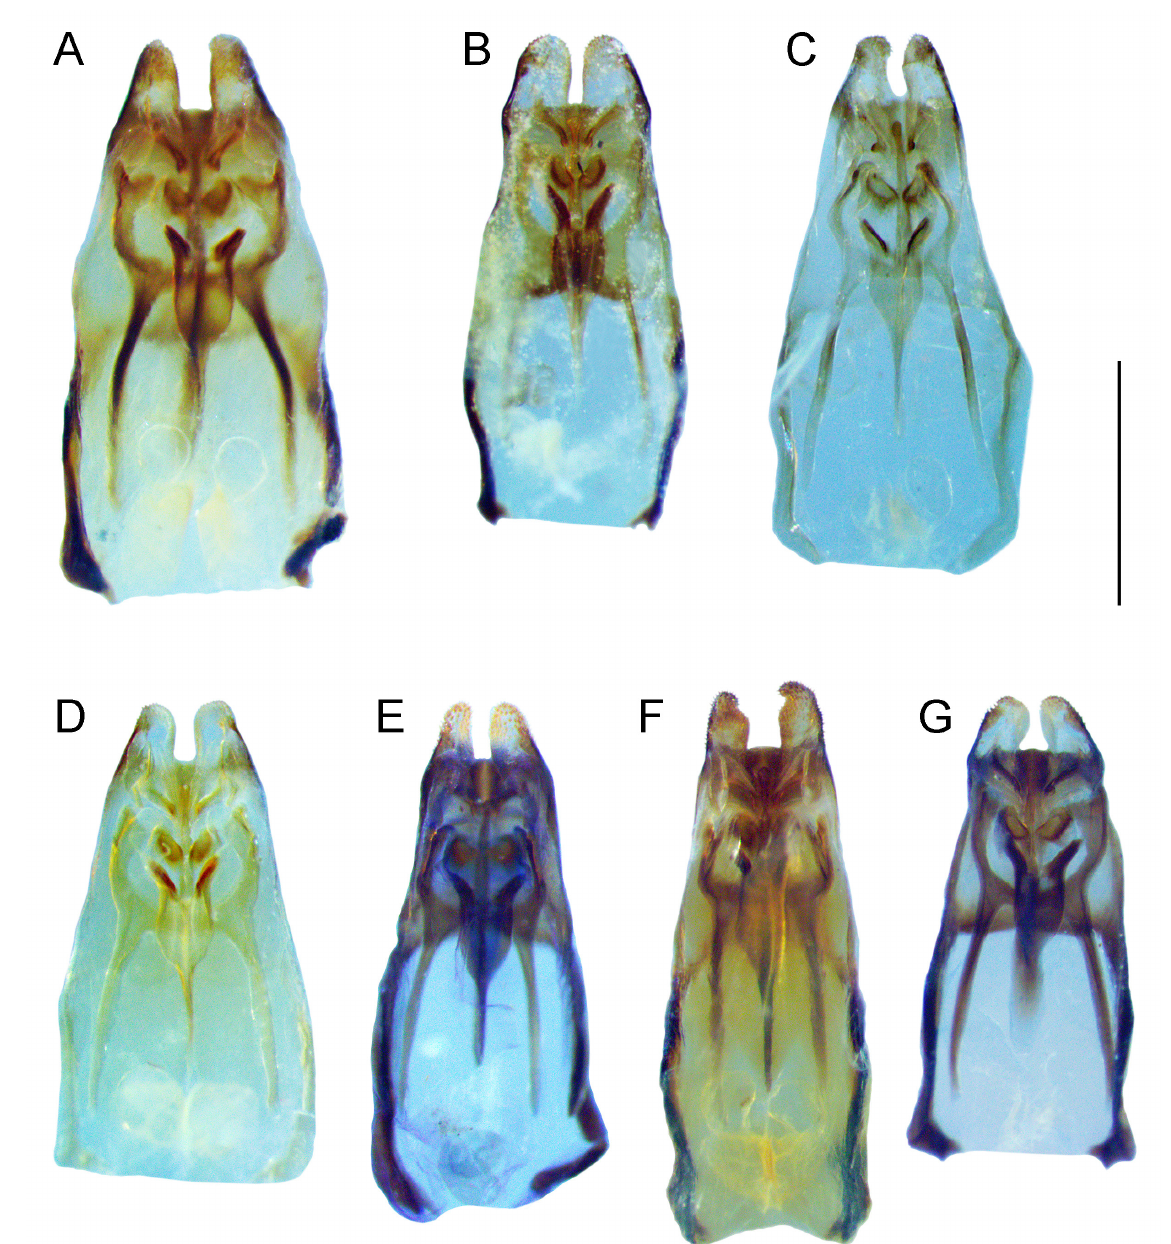
Fig. 16. Male genitalia in ventral view. A . Nisitrus brunnerianus Saussure, 1878. B . N. cruciu s Robillard